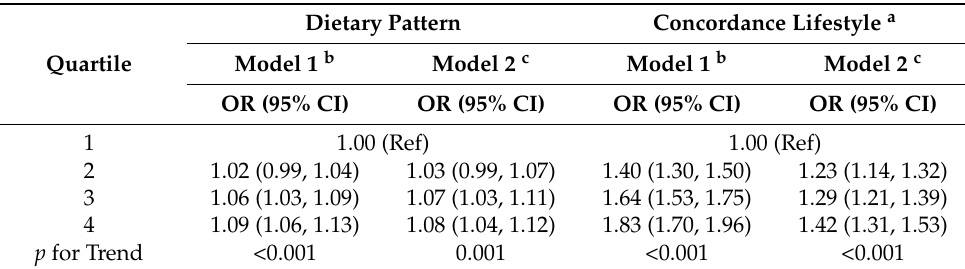
Table 4. Logistic regression models for the association of liver-associated dietary patterns and concordance lifestyle with abnormal liver function ( n = 62,645). Dietary Pattern Concordance Lifestyle a Quartile